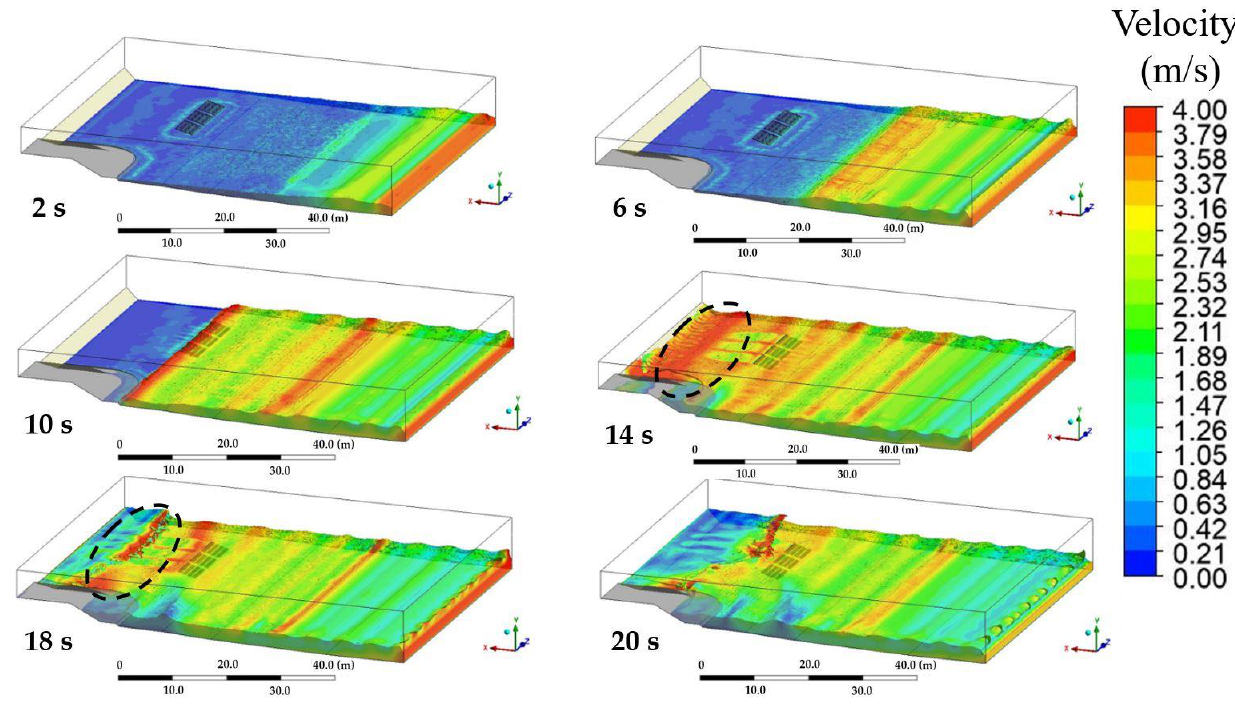
Figure 10. The water velocity for the different times of P1/15 °